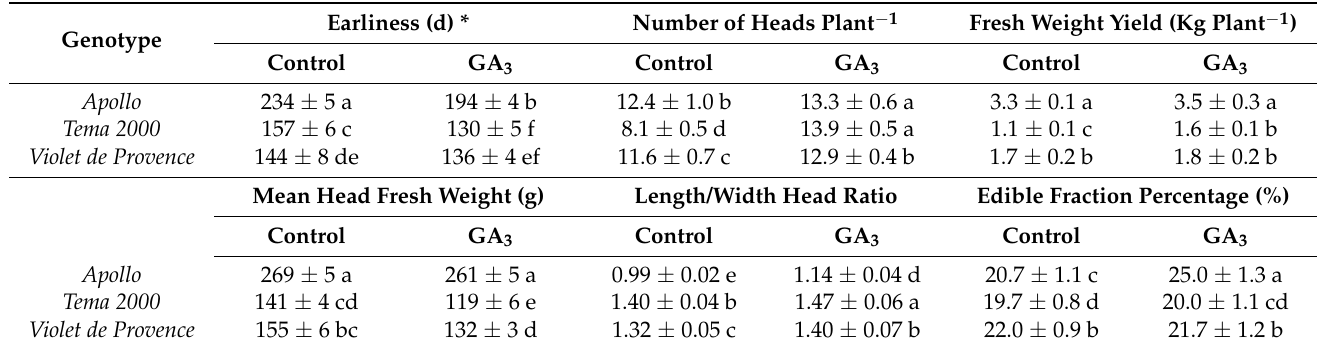
Table 7. Plant growth response and head bio-morphological characterization of globe artichokes as affected by the ‘GA 3 treatment × genotype’ interaction. Different letters within the same parameter show significant differences among means ± s.d. (LSD test, p <